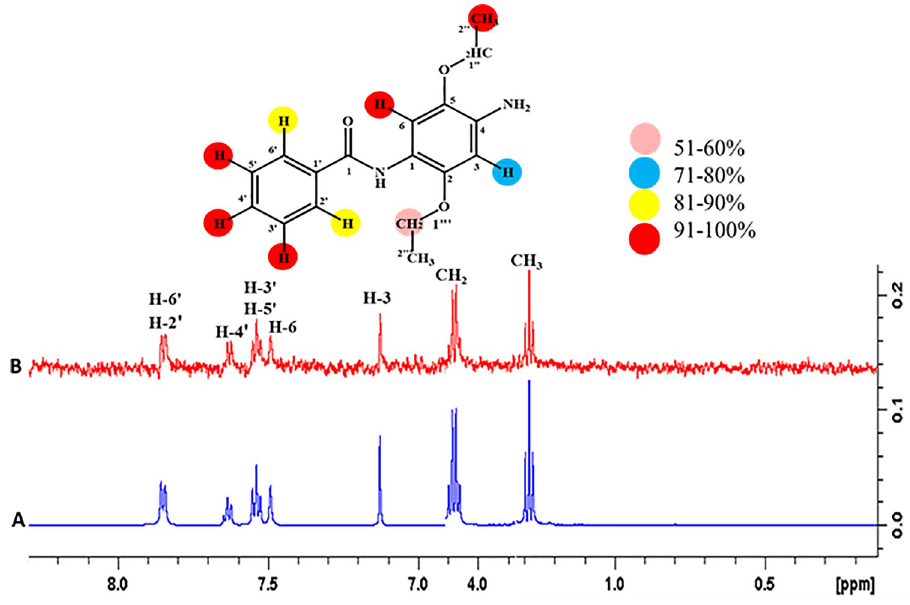
Fig 17. (A) Reference 1 H-NMR spectrum of ligand 2. (B) Difference spectrum of ligand 2 with